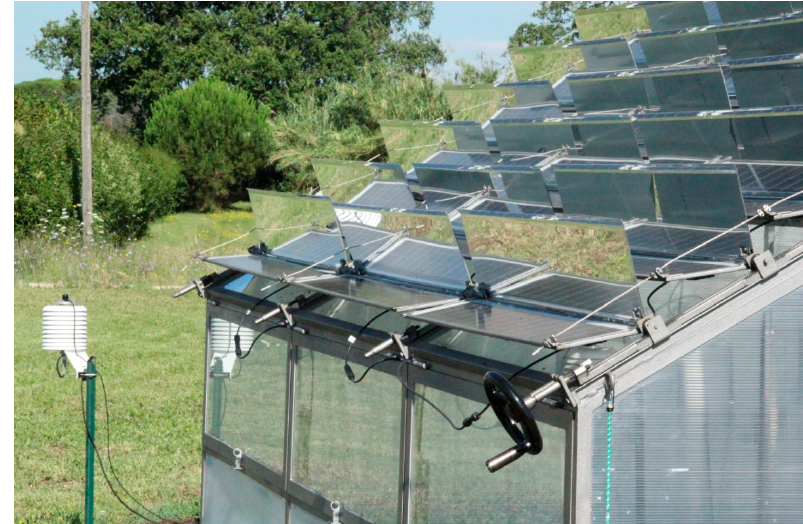
Figure 4. The greenhouse prototype with PV panels fixed in the horizontal position and reflective mirrors aligned with the sun’s rays.